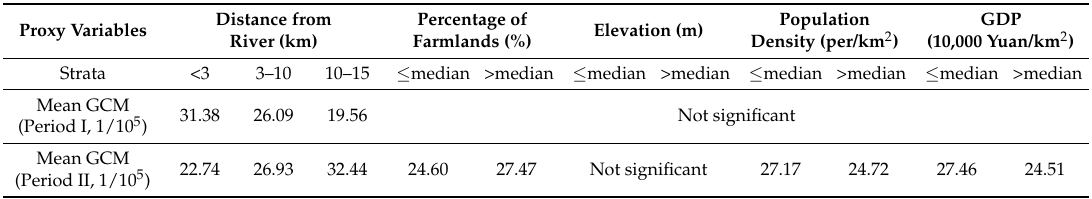
Table 3. Average GCM in each